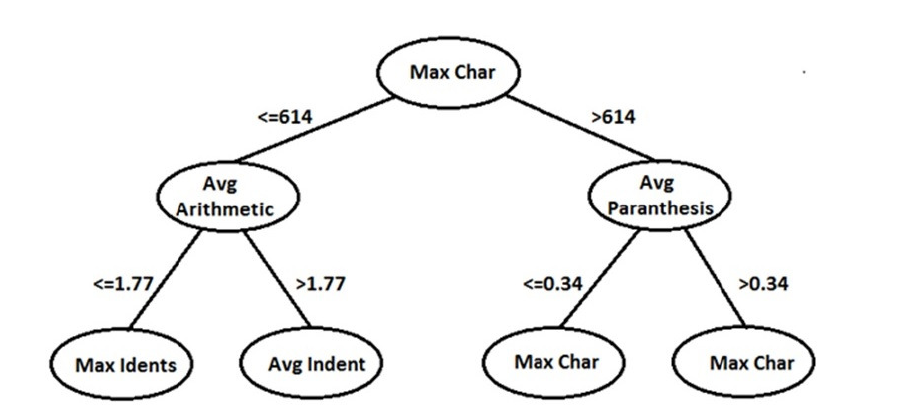
Figure 2. First three levels of the model for case study